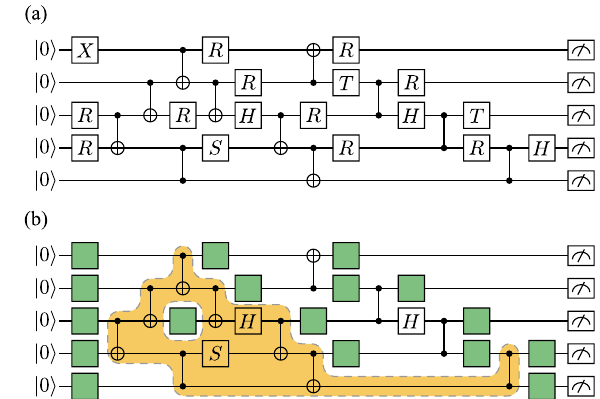
Fig. 4 Quantum circuit and circuit frame. a The circuit for a speci fi c task. Single-qubit gates X , H and S are Clifford, and gates T and R are non-Clifford. b The task-dependent circuit frame. Green boxes are slots for variable single-qubit gates. Clifford gates in the yellow region with dashed borders form a composite Clifford